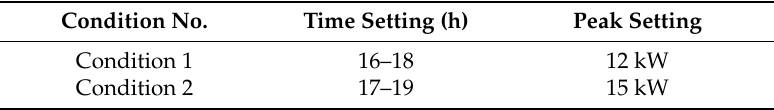
Table 2. The peak control operating